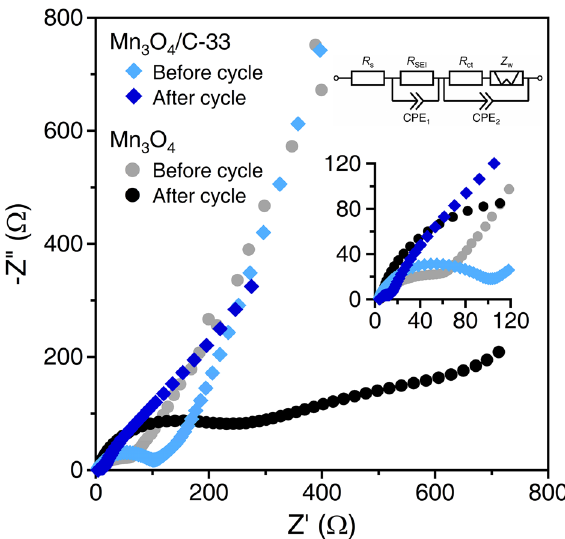
Figure 10. Nyquist plots of bare Mn 3 O 4 and Mn 3 O 4 /C-33 composite anodes before and after five charge– discharge cycles at